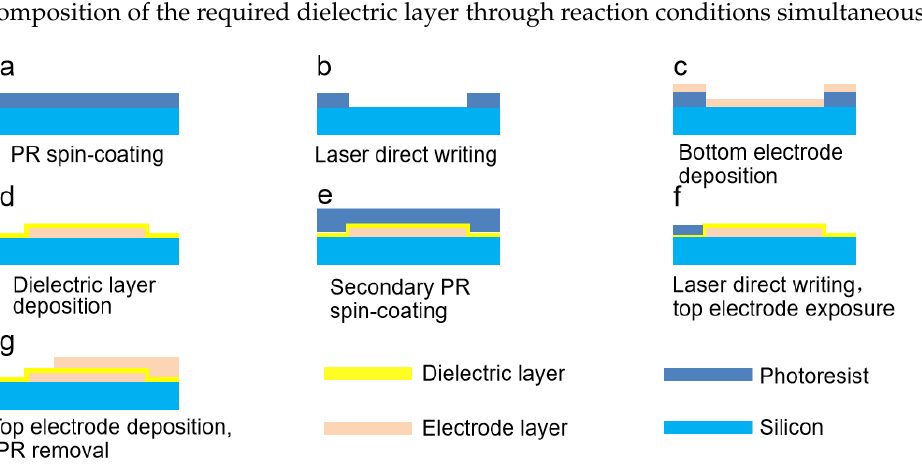
Figure 1. Schematic illustration of fabrication process of MIM capacitors. ( a ) PR spin-coating. ( b ) Laser direct writing. ( c ) Bottom electrode deposition by laser direct writing. ( d ) Dielectric layer deposition by ALD. ( e ) Secondary PR spin-coating. ( f ) Laser direct writing and top electrode exposure. ( g ) Top electrode deposition and PR removal.